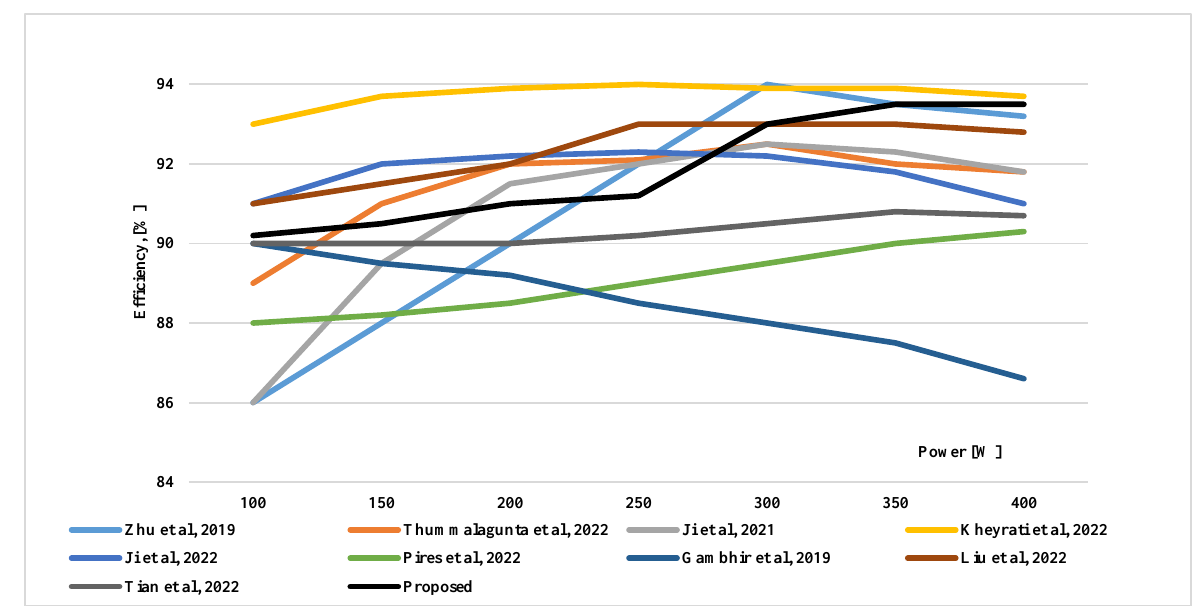
Figure 23. Measured efficiency and comparison with similar topologies [42 – 50].